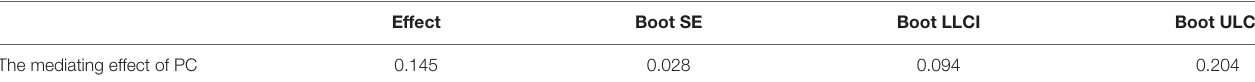
TABLE 13 | The bootstrap mediating effect